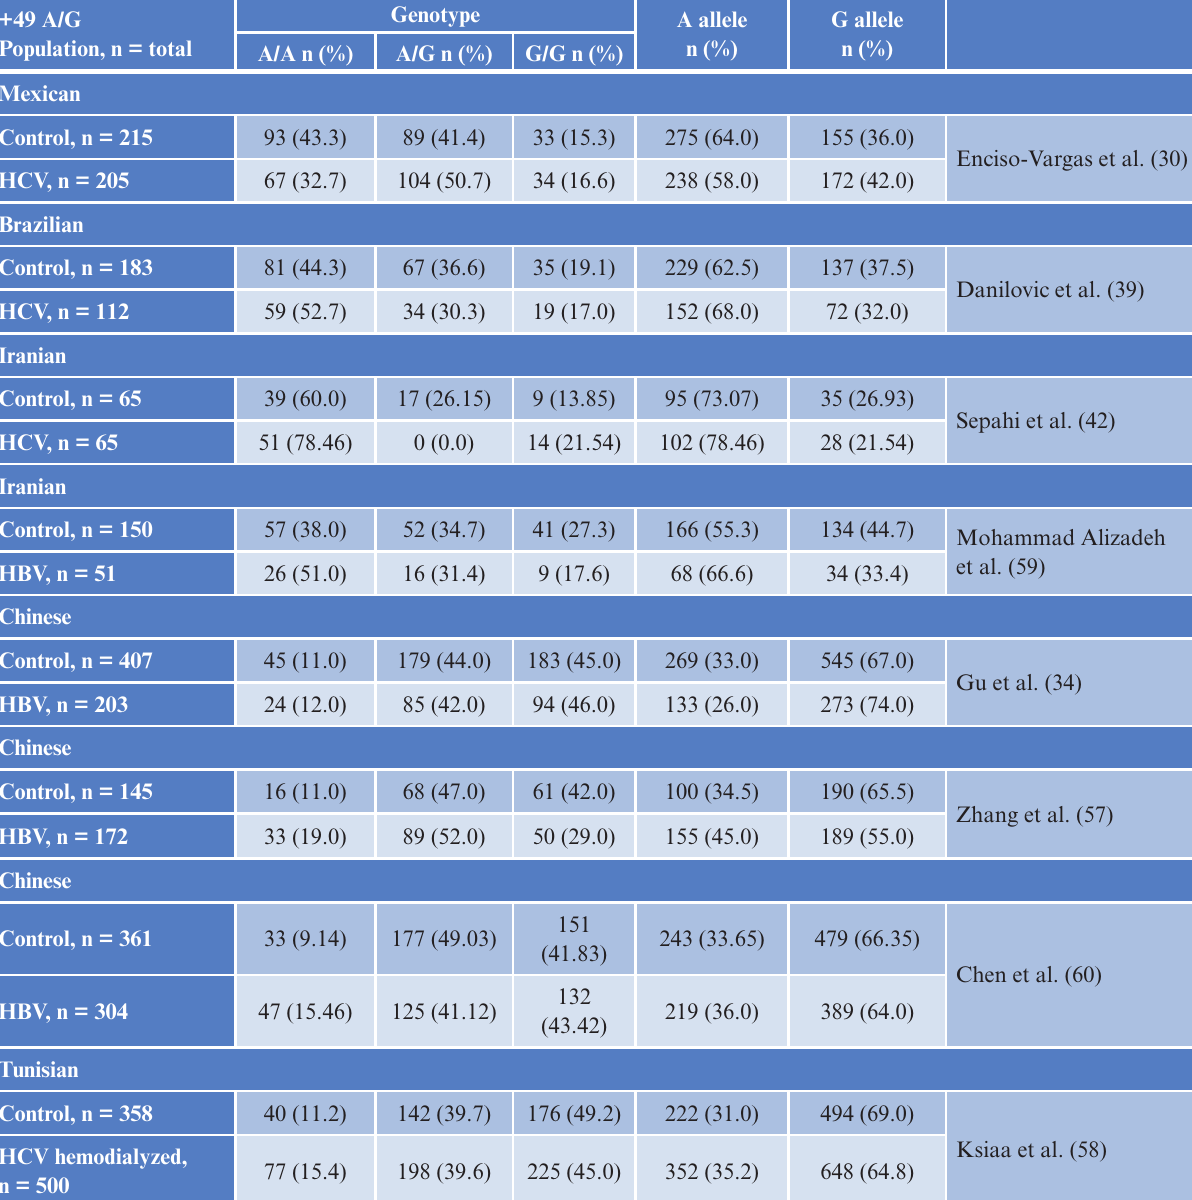
Table 2. Allelic and genotypic frequencies of +49A/G SNP in HCV/HBV infected patients and control subjects +49